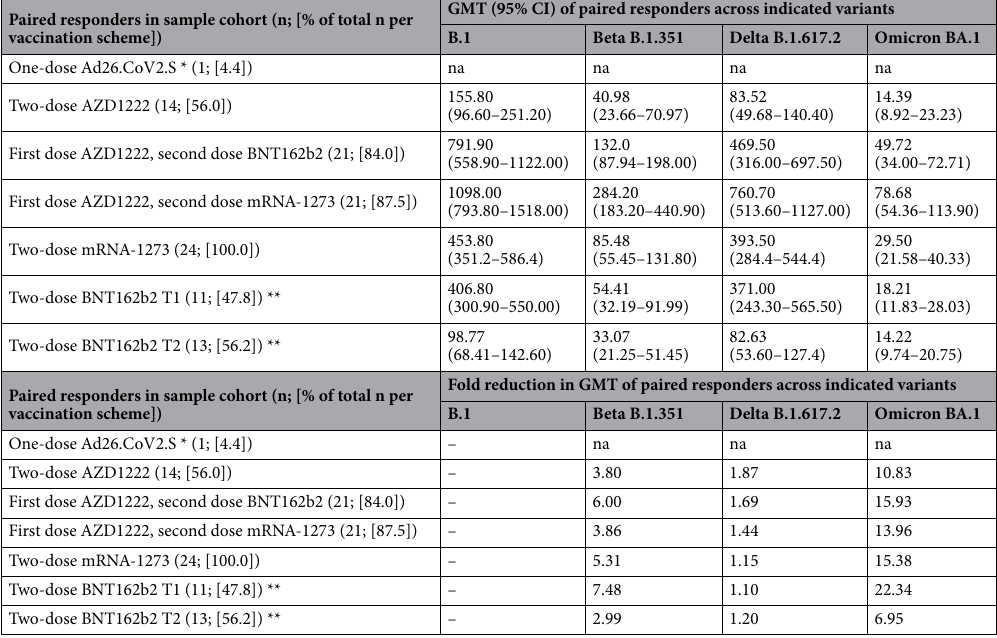
Table 2. Geometric means of responses and fold reduction in paired samples of Omicron responder subsets. *Only one individual showed detectable neutralization titers in the Omicron BA.1 assay.